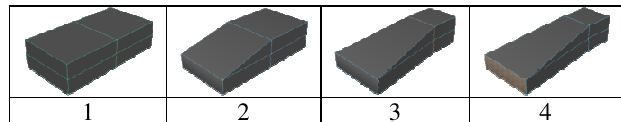
Figure 5. Modeling the Foot (see text for